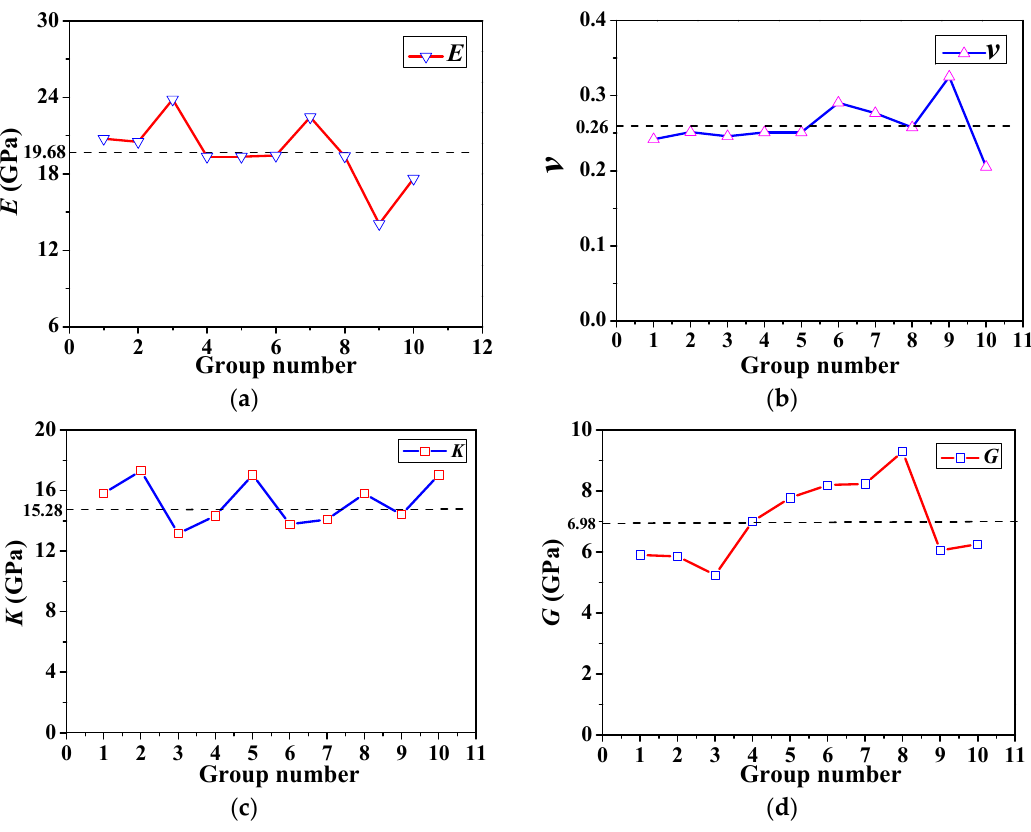
Figure 8. Changes of ( a ) the tensile modulus ( E ), ( b ) the Poisson’s ratio ( v ), ( c ) the bulk modulus ( K ) and ( d ) the shear modulus ( G ) of 10 groups of repeated simulation calculated using the PCFF force field. The average values ( µ ), standard deviations ( s ), and maximum deviation factors ( β ) for the data for the 10 groups for each force field were determined. The average value reflects the centrotaxis of the data. The standard deviation represents the discreteness of the data, which can be used to indicate the degree of dispersion, and a large standard deviation means a greater degree of discretization. The maximum deviation factor is the absolute difference between the maximum (minimum) sample value and average value divided by the average value. The average value, standard deviation, and maximum deviation factor of E and v for the data for the 10 groups for each force field are presented in Table 4. Table 4. Average value, standard deviation, and maximum deviation factor of E and v calculated using COMPASS and PCFF force fields.